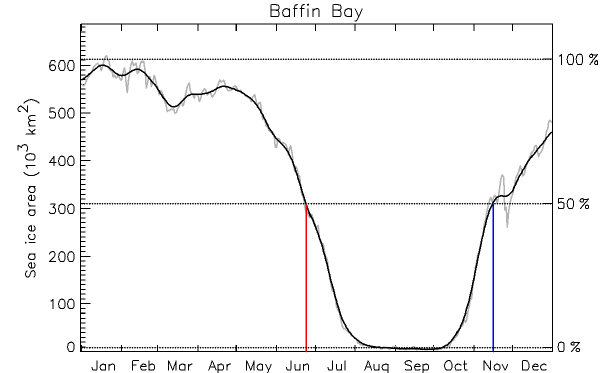
Figure 3. Determination of the spring and fall transition dates for the year 2005 in Baffin Bay. The gray curve is the daily sea-ice area; the black curve is a smoothed version. The horizontal dotted line (at 311 × 10 3 km 2 ) is the threshold. The intersection of the threshold with the smoothed (black) curve determines the spring (red) and fall (blue) transition